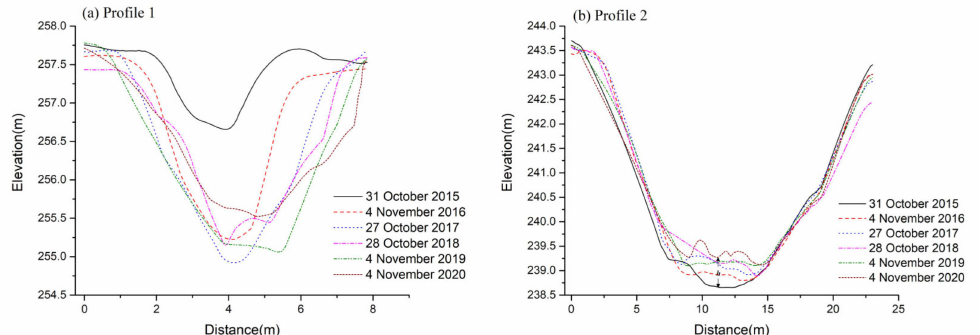
Figure 9. Profiles 1 ( a ) and 2 ( b ) illustrate surface changes from 2015 until 2020 in the gully. h , the elevation difference at the bottom of the gully bed between 2015 and